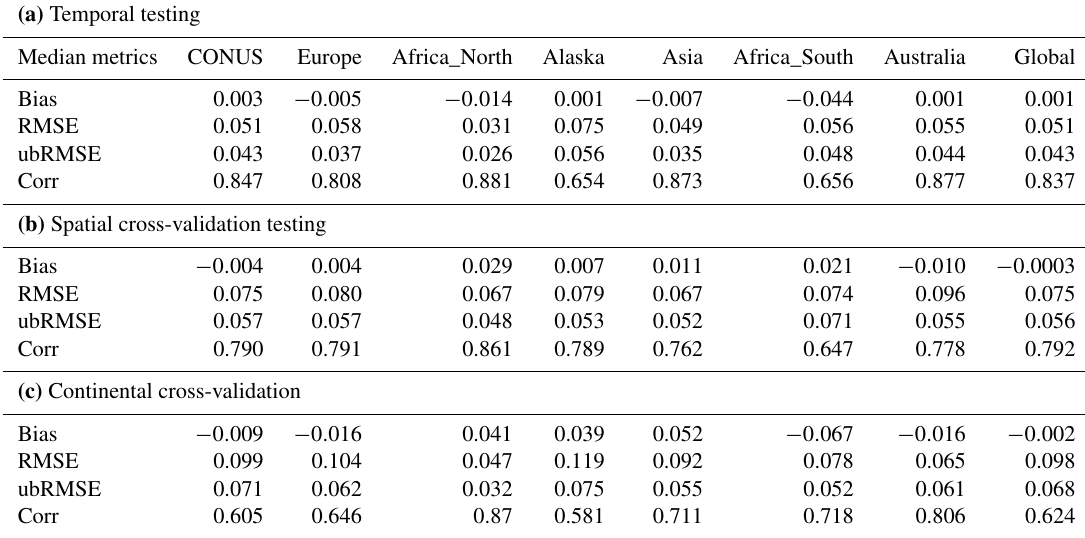
Table 1. Model performance in three scenarios. (a) The model’s temporal testing in different regions. (b) The model’s spatial cross-validation testing in different regions. (c) The model’s continental cross-validation testing in different